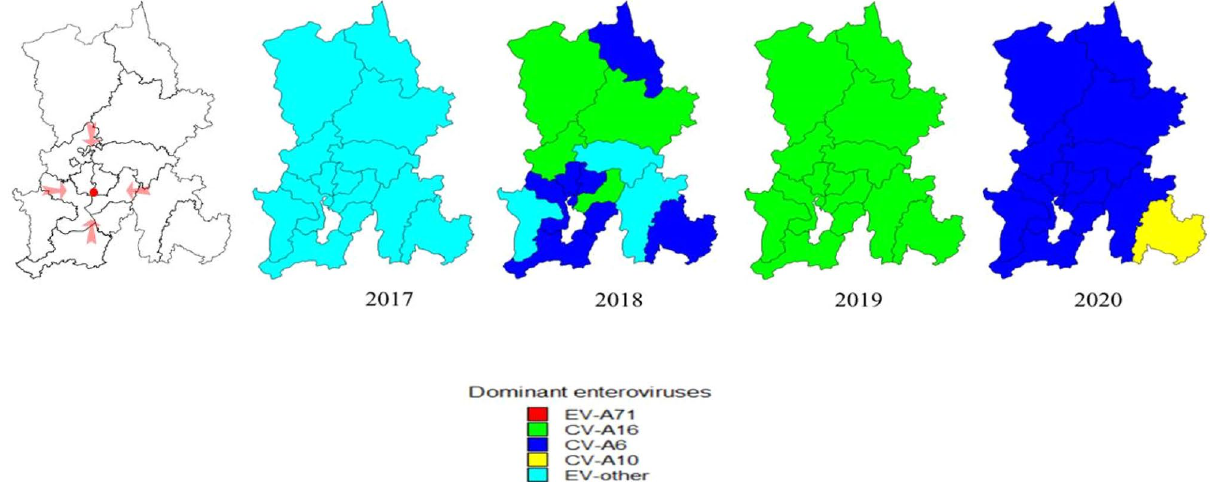
Figure 4. The spatial distribution map of other enteroviruses as dominant enteroviruses of districts and counties in Kunming, 2017–2020. The red dot shows the location of Kunming Children’s Hospital, which is located at the junction of the main urban area. In 2017, the areas with a high proportion of other enteroviruses as dominant enteroviruses were Shilin (100%), Yiliang (94.7%), Anning (89.3%), Chenggong (85.1%) and Luquan (79.0%). In 2018, CV-A16 was mainly prevalent in Luquan (43.5%), Xundian (39.3%), Fumin (37.6%) and Guandu (33.2%); CV-A6 was mainly prevalent in Shilin (60.0%), Dongchuan (49.5%), Jinning (45.8%), Chenggong (37.8%) and Wuhua (36.5%). In 2019, the areas with a high proportion of CV-A16 as dominant enteroviruses were Jinning (59.9%), Yiliang (55.8%), Chenggong (49.5%), Panlong (48.4%) and Anning (48.2%). In 2020, CV-A6 was mainly prevalent in Luquan (77.4%), Dongchuan (75.7%), Anning (74.5%), Fumin (74.1%) and Xundian (73.4%); CV-A10 was mainly prevalent in Shilin (50.0%), Songming (19.1%) and Yiliang (17.1%). This figure was drawn by MapInfo 10.0 spatial distribution software [url = http:// www.i- mapin fo. com]